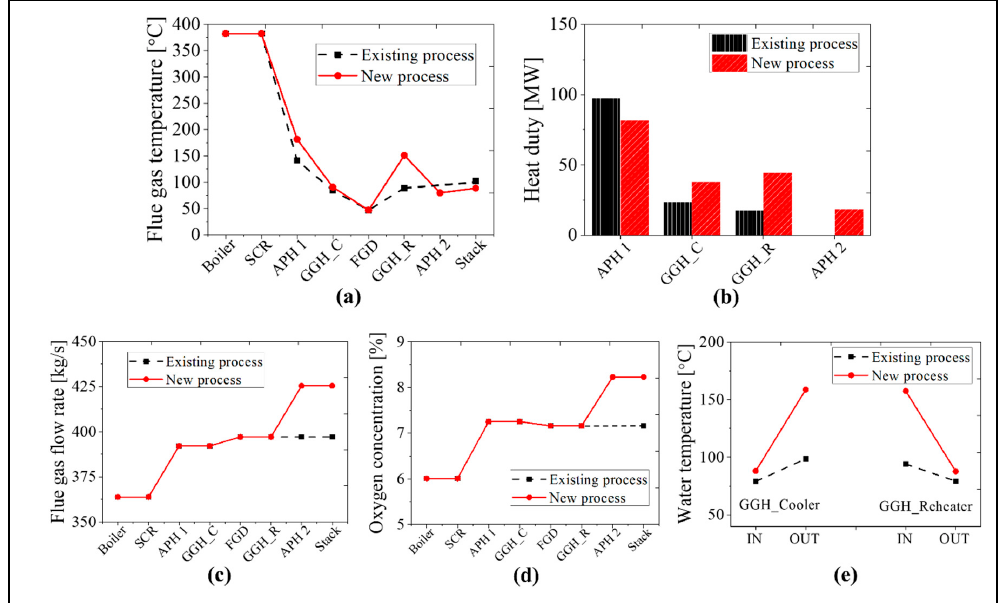
Figure 13. A comparison of the results for the existing and new processes at 30% TMCR load condition: ( a ) flue gas temperature, ( b ) heat duty, ( c ) flue gas flow rate, ( d ) oxygen concentration, and ( e ) the water temperature of the GGH.